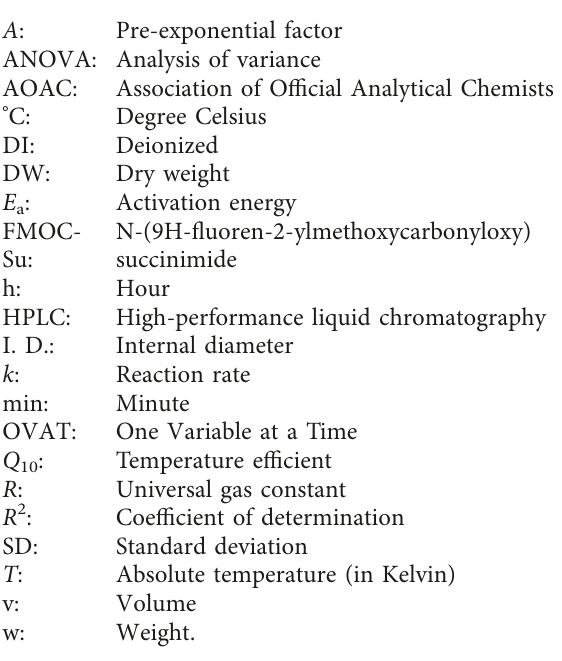
Table 3: The kinetics parameters for mushroom hydrolysis. Raw